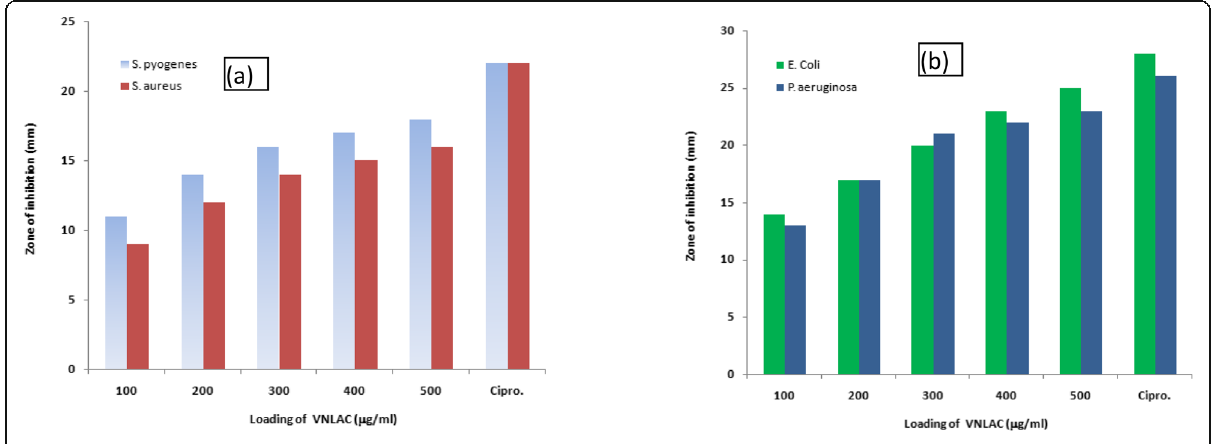
Fig. 8 Antimicrobial activity of VNLAC against Gram-positive pathogens ( a ) and Gram-negative pathogens ( b )